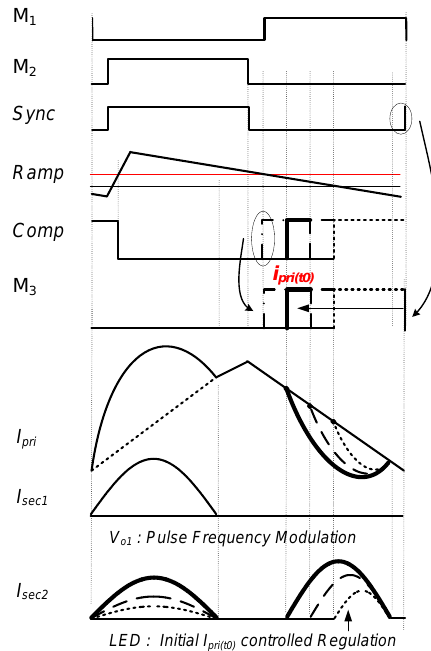
Figure 3. Control method of proposed converter.